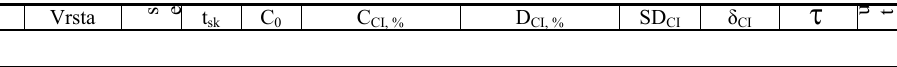
Rezultati ispitivanja sadržaja stabilizatora NGB